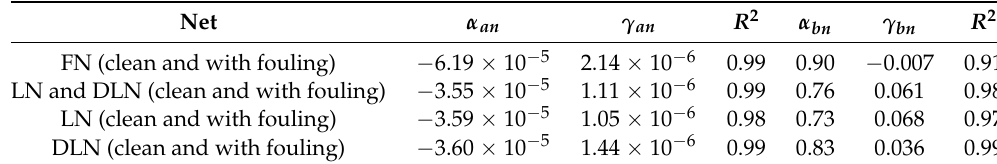
Table 5. Coefficients γ and α for a n = α an S n + γ an and b n = α bn S n + γ bn fitting for normal drag coefficient experiments.